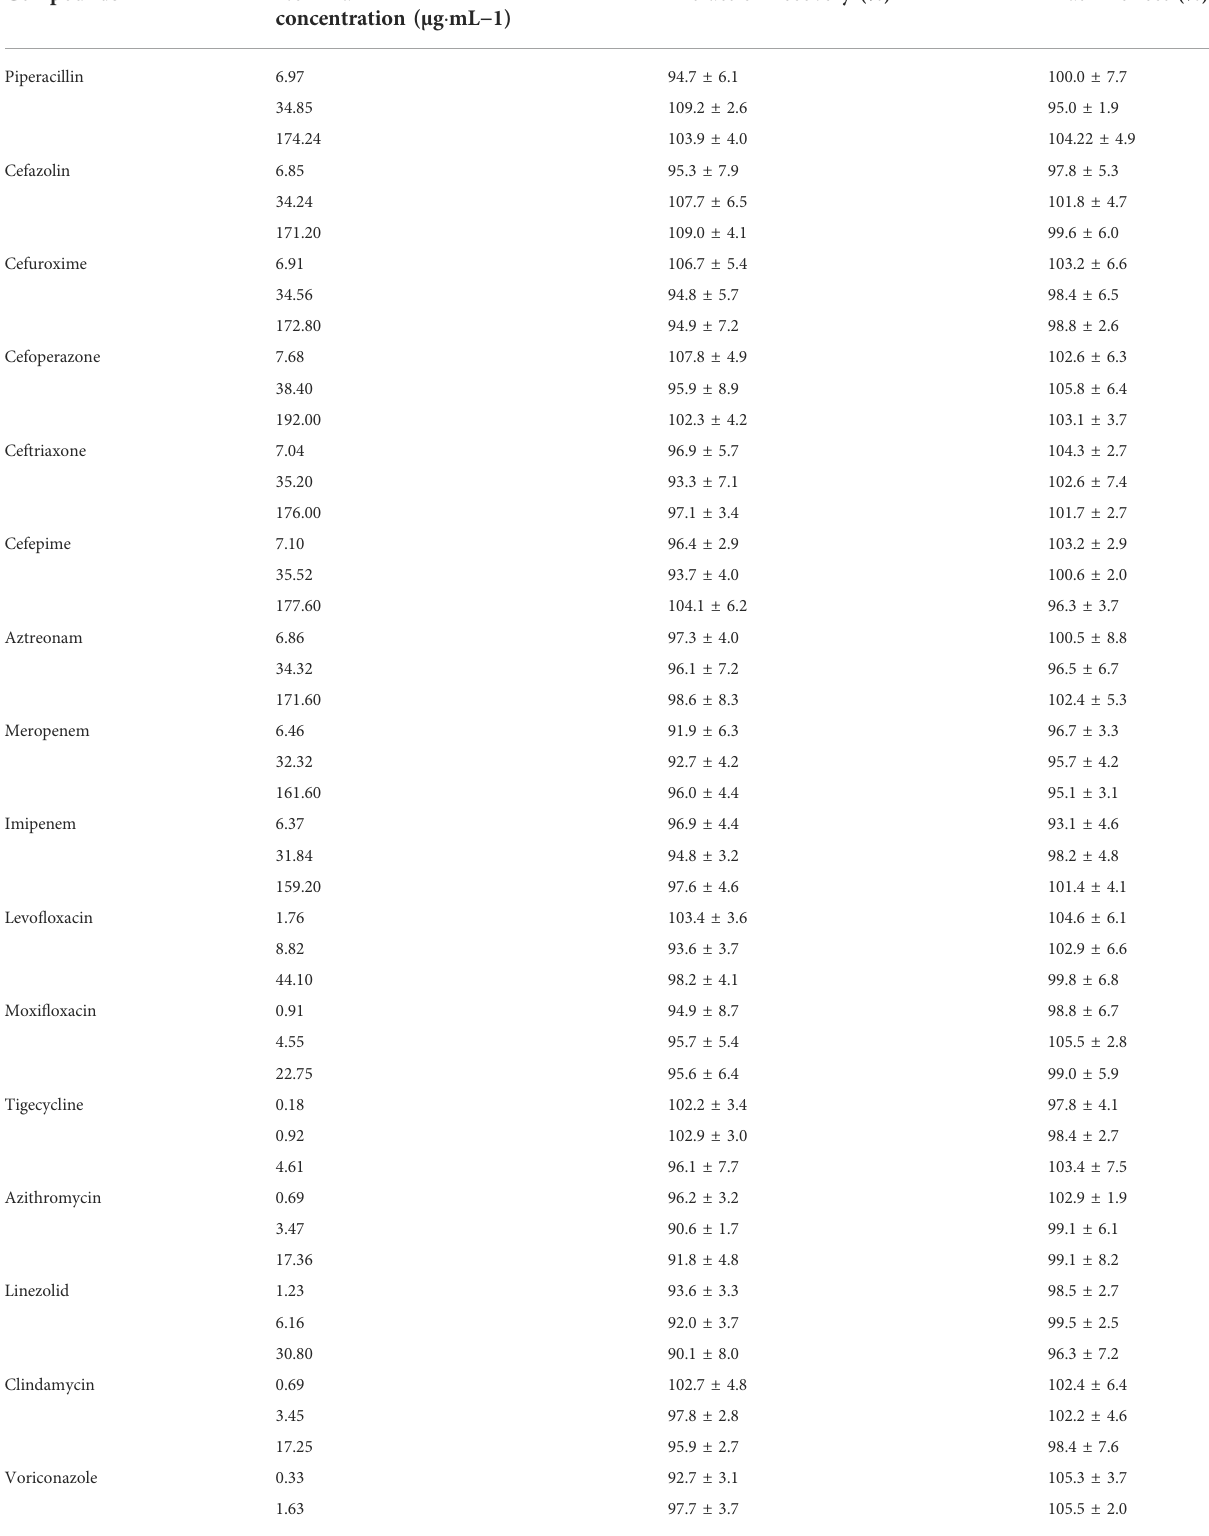
TABLE 5 Matrix effects and extraction recoveries of 18 antimicrobial agents in human plasma (mean ± RSD, n = 6).